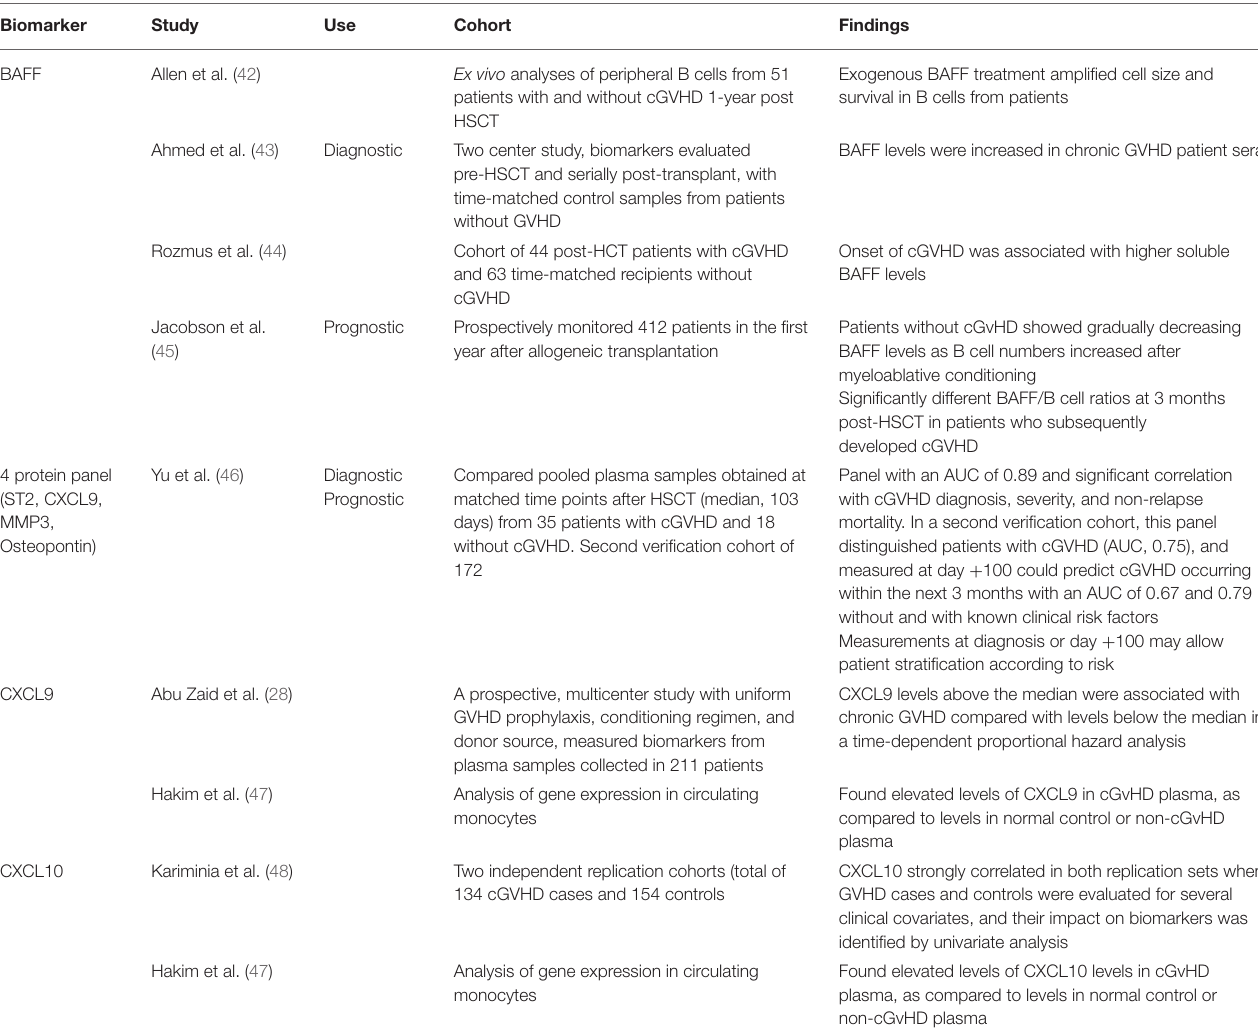
TABLE 2 | Summary of biomarkers for chronic GvHD.